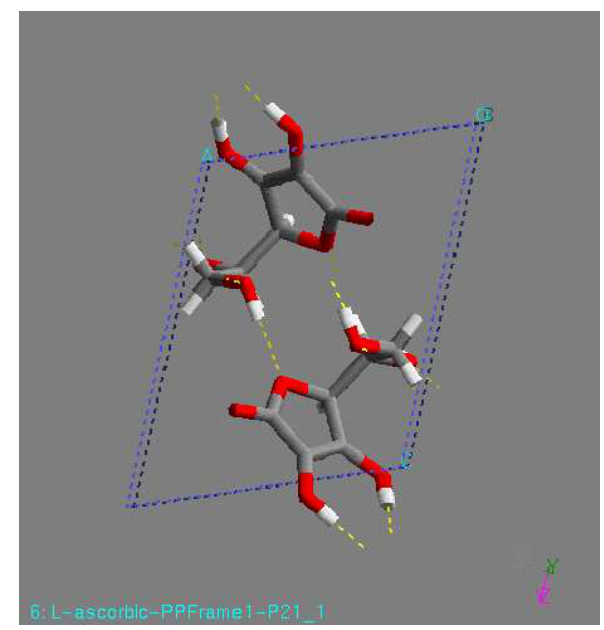
Figure 2. P21 structure, found by minimization. This structure had the lowest lattice energy in the DREIDING force field. View along the